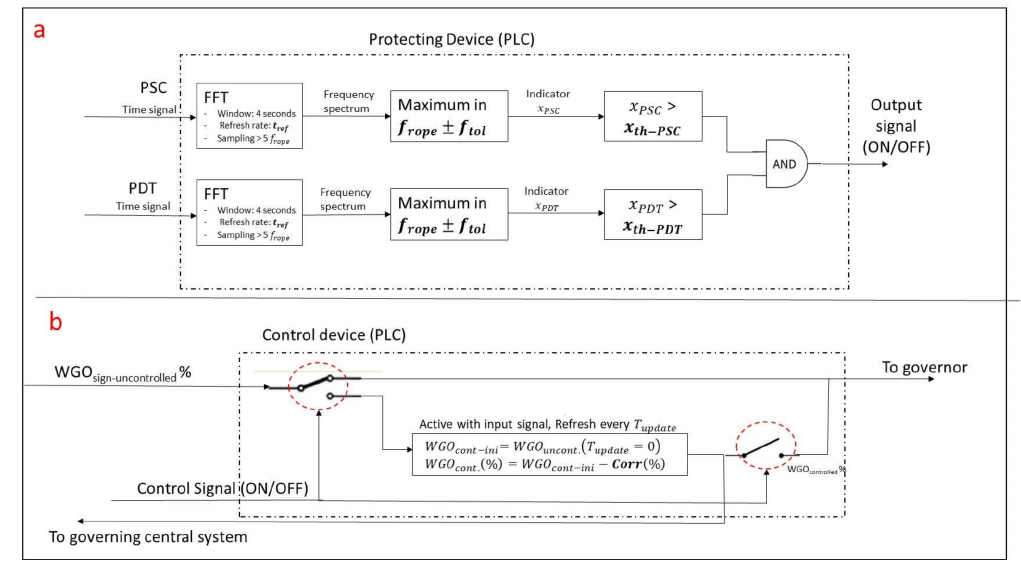
Figure 19. ( a ) Scheme of the protection device. ( b ) Scheme of the control device.